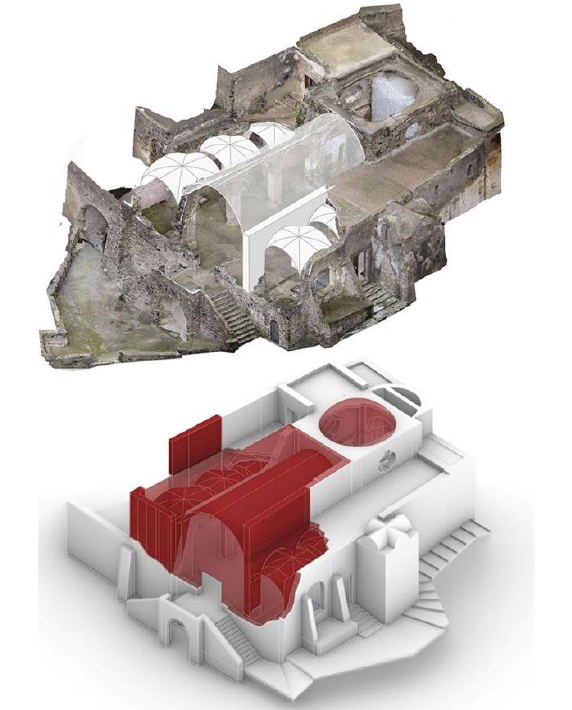
Figure 9. Overlapping between point cloud and digital